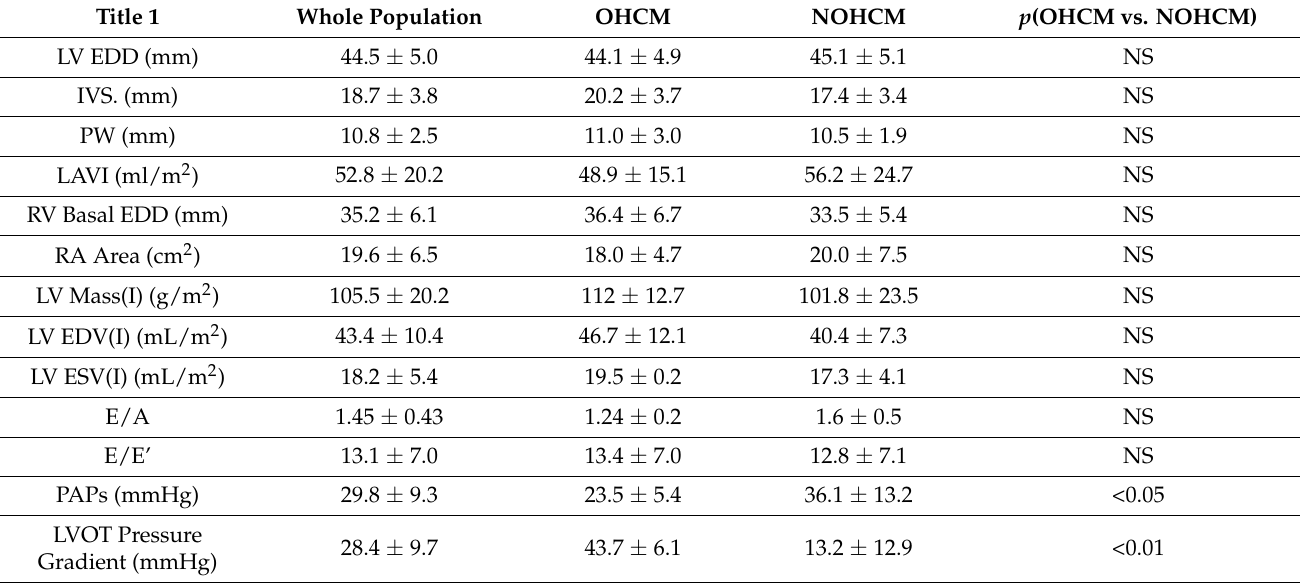
Table 2. Echocardiographic data of the study population.